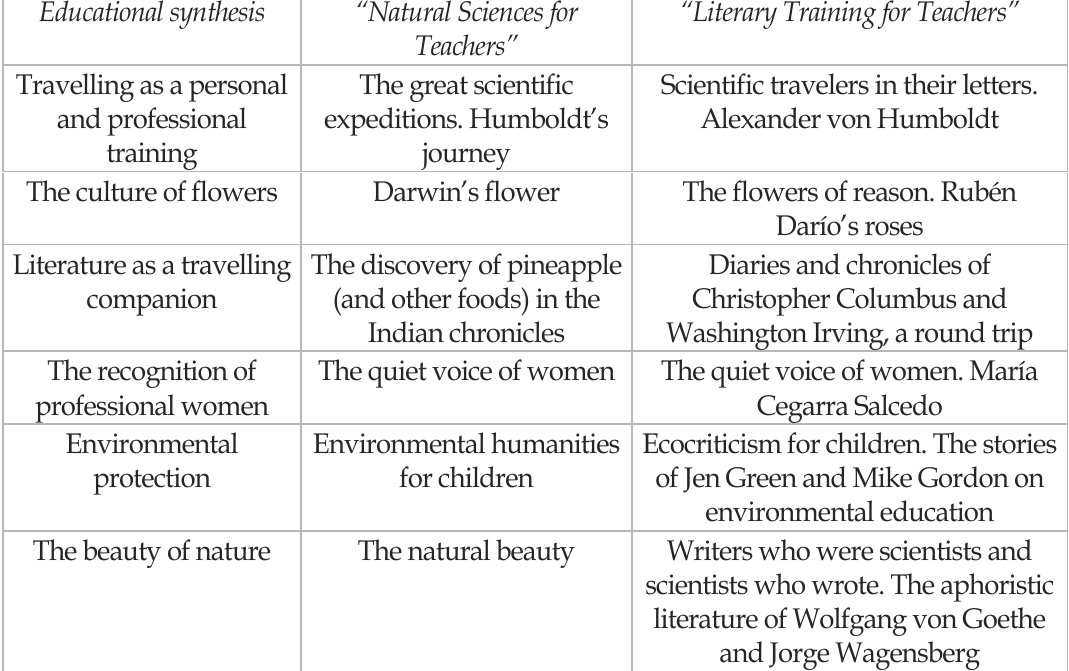
Table 1 . Educational synthesis and topics for both subjects. Educational